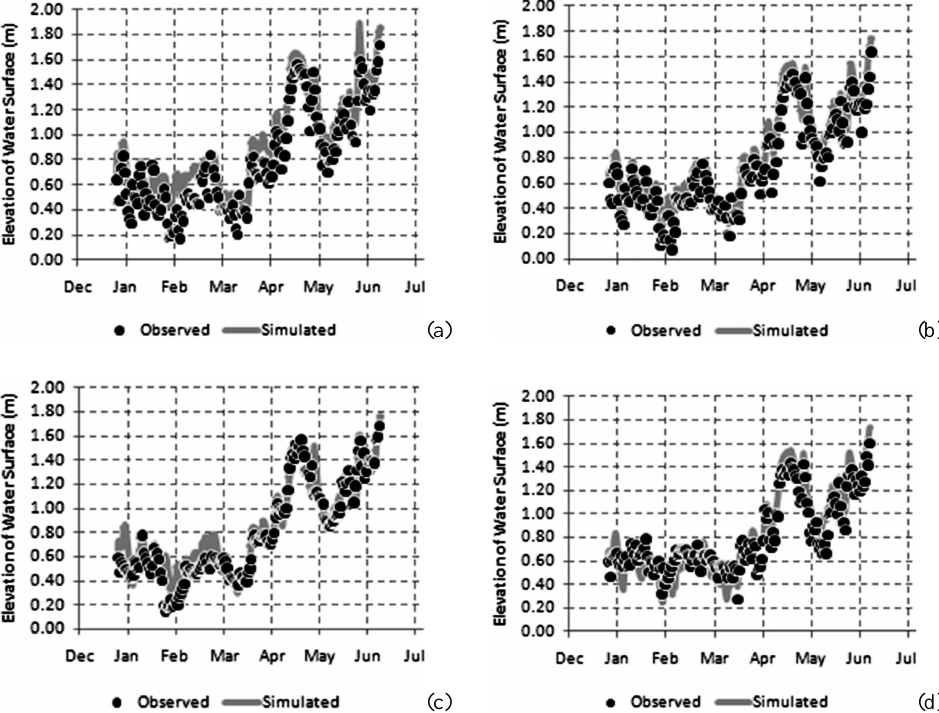
Fig. 4. Calculated and observed elevation of water surface at four control points along the Guaíba River: (a) Ilha da Pintada; (b) Ipanema; Fig. 4: Calculated and observed elevation of water surface at four control points along the River Gua´ıba: (a) Ilha da Pintada; (b) Ipanema; (c) Cristal and Fig. 4: Calculated and observed elevation of water surface at four control points along the River Gua´ıba: (a) Ilha da Pintada; (b) Ipanema; (c) Cristal and (c) Cristal and (d) Ponta Fig. 4: Calculated and observed elevation of water surface at four control points along the River Gua ´ ıba: (a) Ilha da Pintada; (b) Ipanema; (c) Cristal and Fig. 4: Calculated and observed elevation of water surface at four control points along the River Gua´ıba: (a) Ilha da Pintada; (b) Ipanema; (c) Cristal and (d) Ponta Grossa. (d) Ponta Grossa. (d) Ponta Grossa. (d) Ponta Grossa.